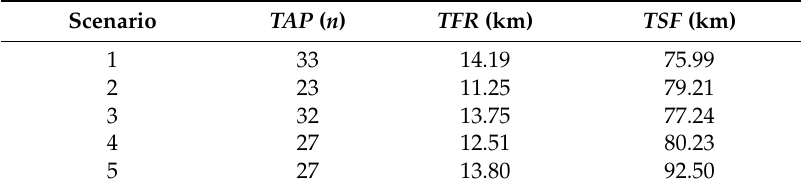
Table 4. Total number of allocated yards ( TAP ), forest roads ( TFR ), and skidtrails ( TS ) for each scenario.